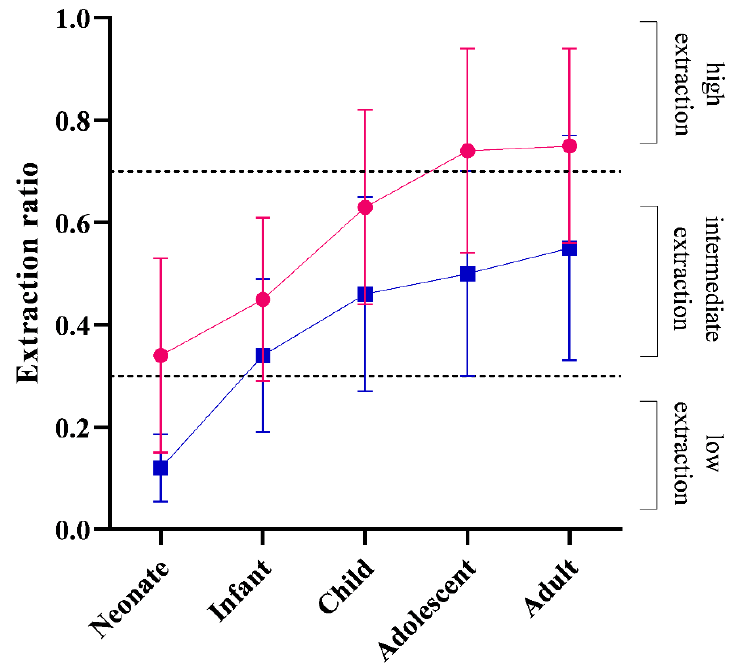
Figure 1. Predicted changes in hepatic extraction ratio (E H ) and renal extraction ratio (E R ) with age. Red circle and line: E H ; blue circle and line: E R ; black broken lines: low extraction ratio target (0.3) and high extraction ratio target (0.7). Data points and error bars represent mean and standard deviations of predicted extraction ratios, respectively.